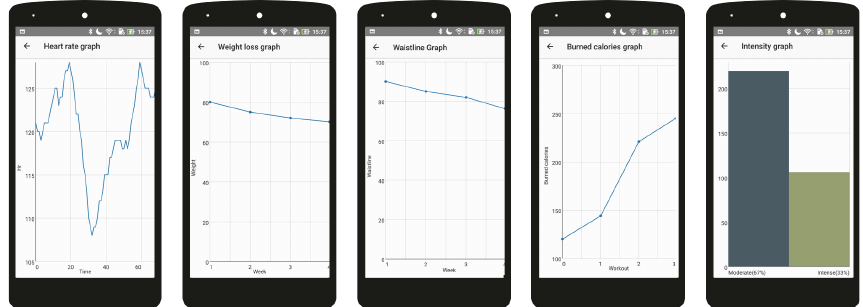
Figure 4: Screenshots from the GUI of the Muoviti!